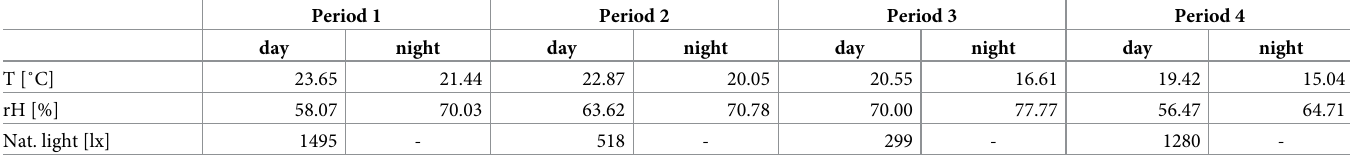
Table 6. Indoor environmental data. Characterization of temperature, relative humidity and natural light (average values) measured in the four periods of the